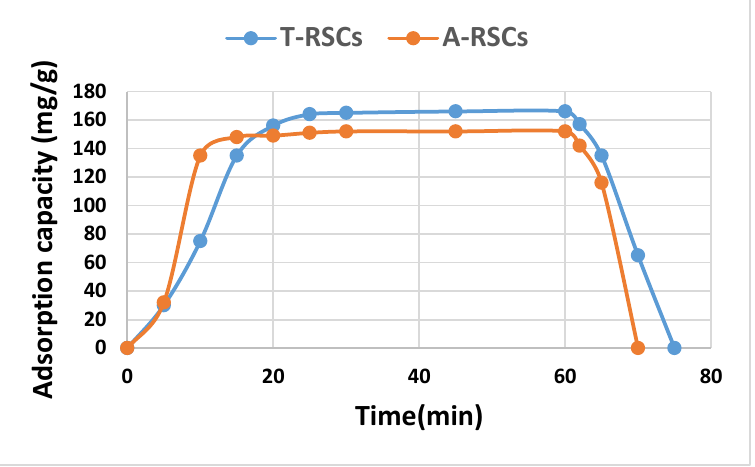
Figure 6. Adsorption capacity of toluene and acetone on rapeseed cake biochar activated with H 2 SO 4 (T-RSCs and A-RSCs).